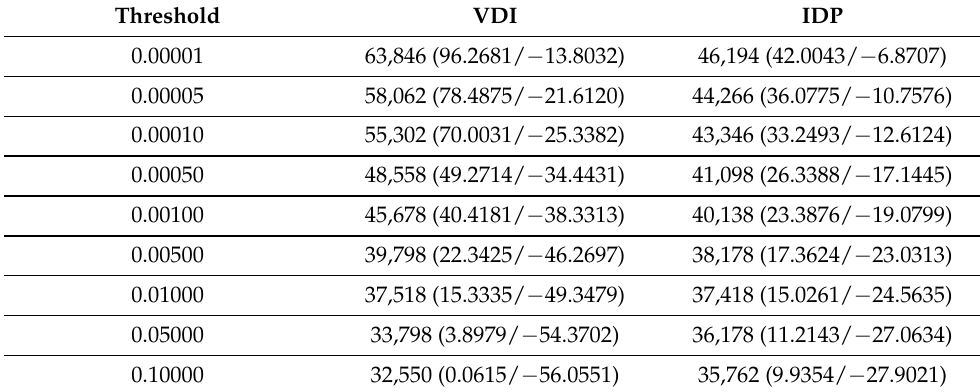
Table 8. hepar2 —Global approximation memory size analysis.